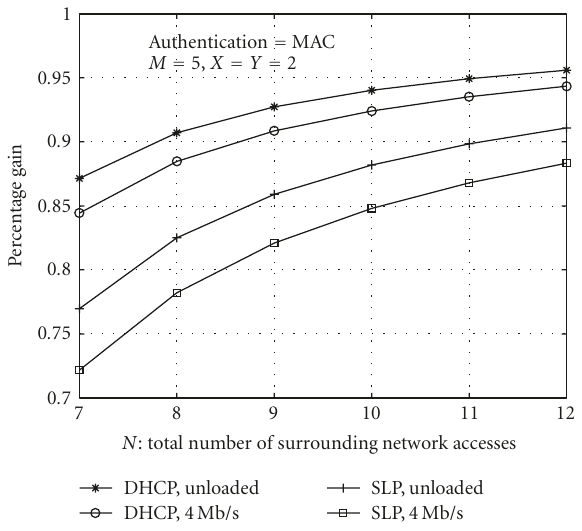
Figure 17: Percentage gain versus N : UAM-based authentication.